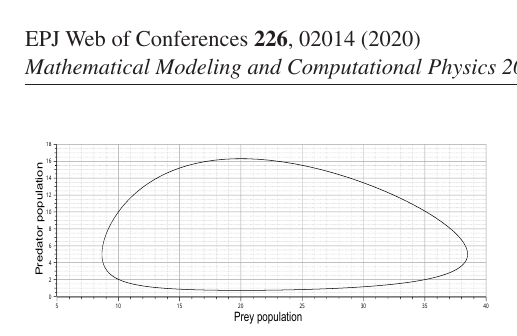
Figure 2. The phase trajectory of the system with